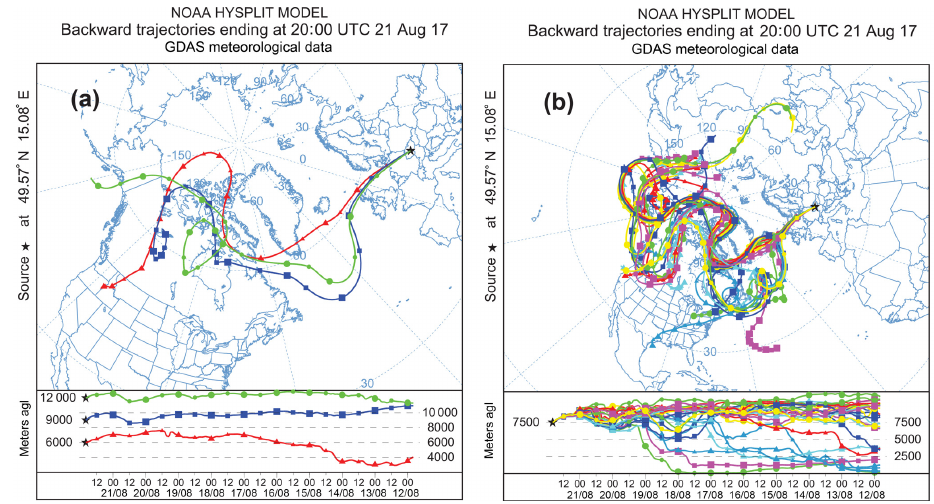
Figure 3. Ten-day backward trajectories (Stein et al., 2015; HYSPLIT, 2018) arriving at Kosetice, Czech Republic, on 21 August 2017, 20:00UTC at heights of (a) 6km (red), 9km (blue), and 12km (green) above ground level, and (b) an ensemble of trajectories for the arrival height of 7.5km. The trajectories show that the smoke source region is the North American